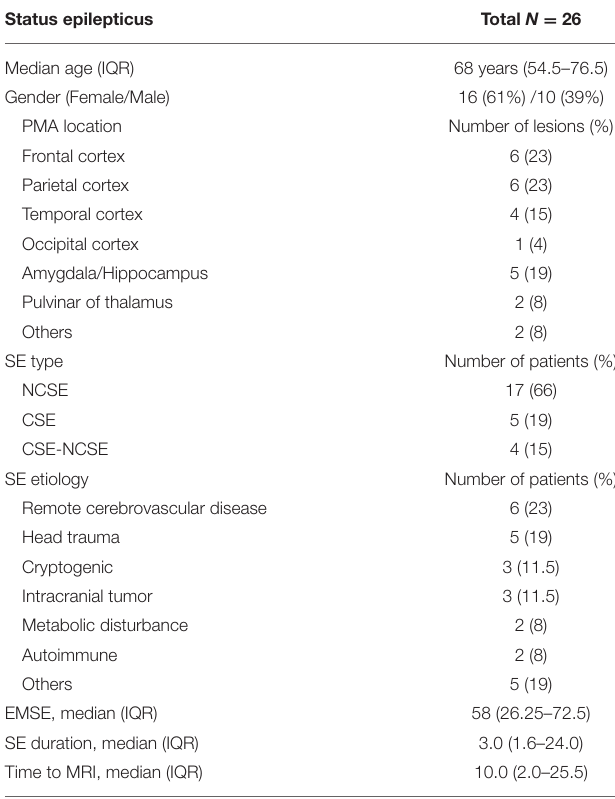
TABLE 1 | Demographic, clinical, and MRI characteristics of patients with